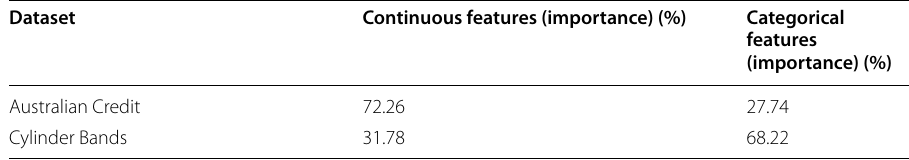
Table 11 Job parameters Parameter Value Number of executors Number of cores per executor spark.locality.wait spark.task.cpus